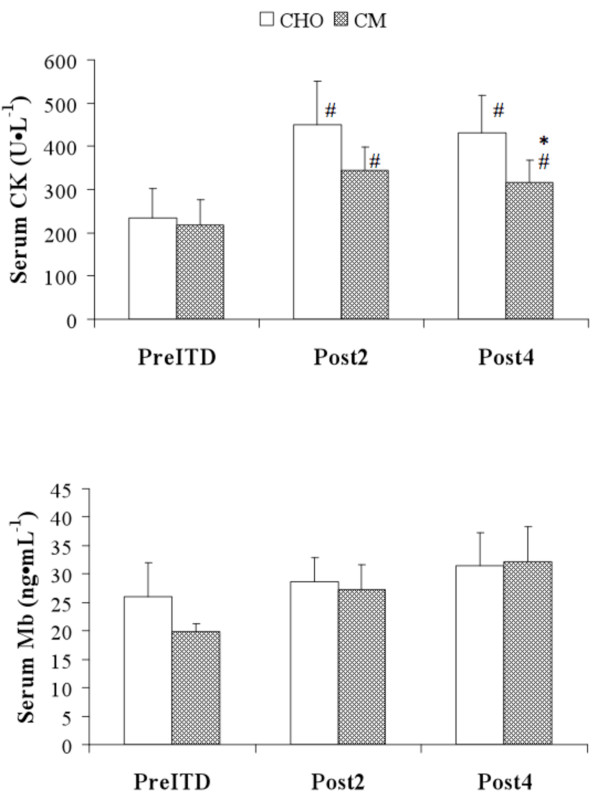
Serum CK and Mb levels following Increased Training Duration. Data reported are means/standard error. [* = significantly different (p < 0.05) than CHO; # = significantly different than PreITD].